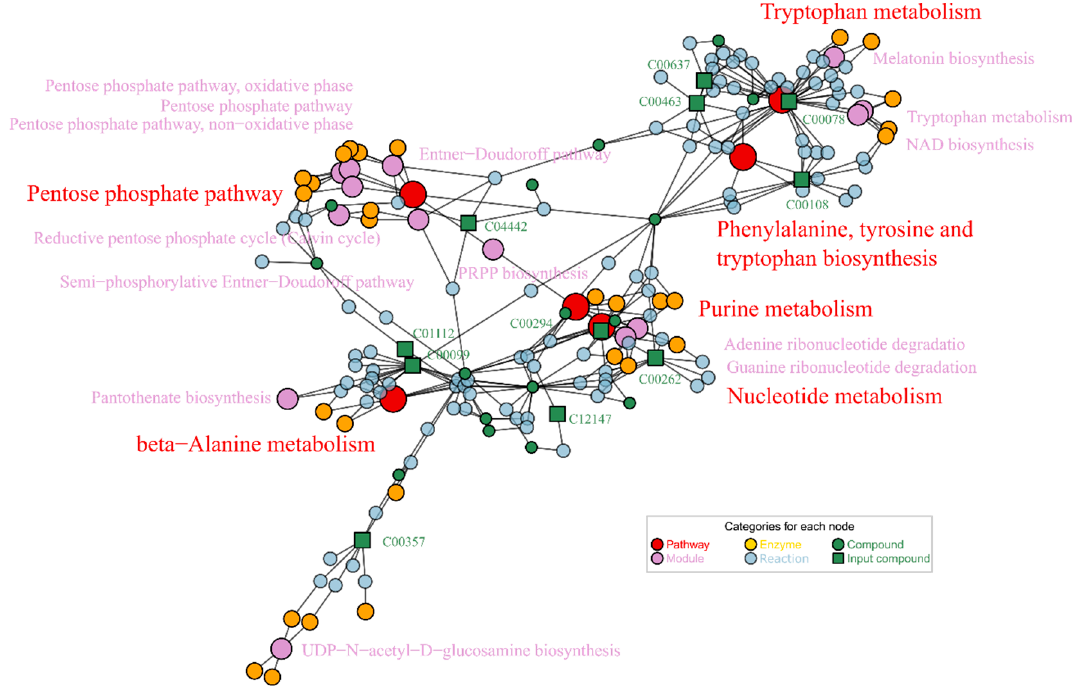
Figure 5. Enriched KEGG nodes based on differential metabolites of Vc1/CL2006 contrast.